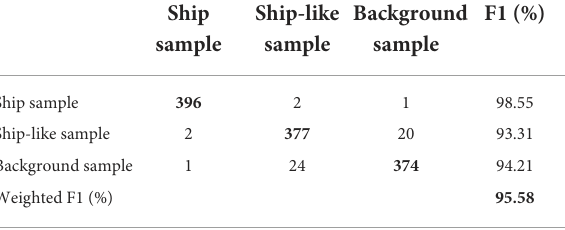
TABLE 2 Confusion matrix of the ship recognition results using the proposed